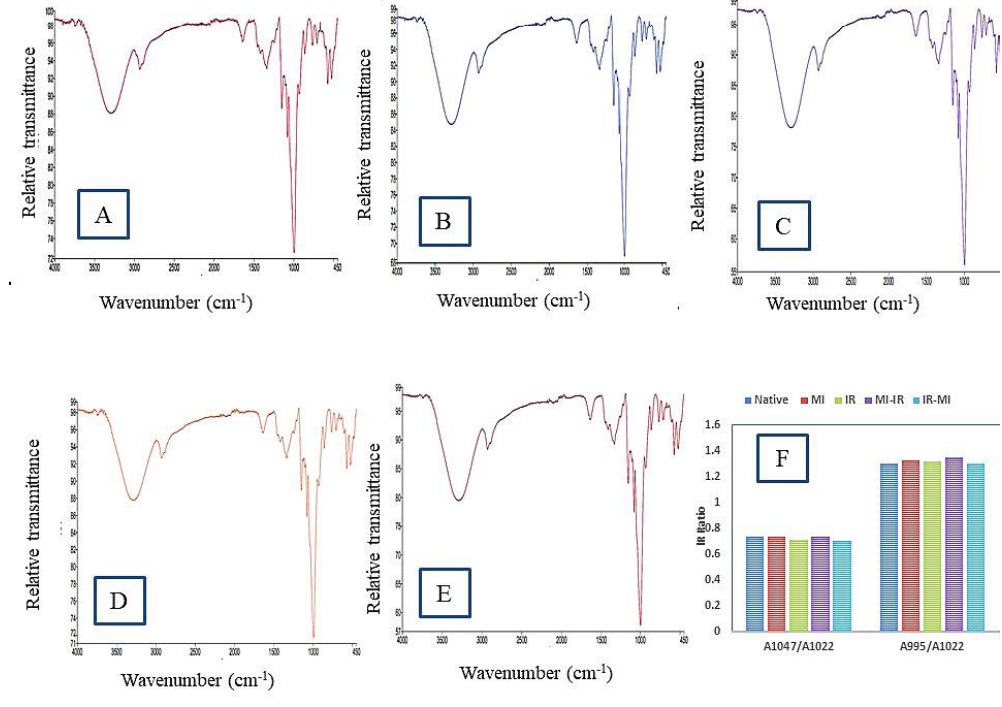
Figure 3. FTIR spectra of native and modified lotus rhizome starches. ( A )—Native; ( B )—MI; ( C )— IR; ( D )—MI-IR; ( E )—IR-MI; ( F )—IR—ratios for absorbance 1047/1022 and 995/1022 of native and modified LRS.